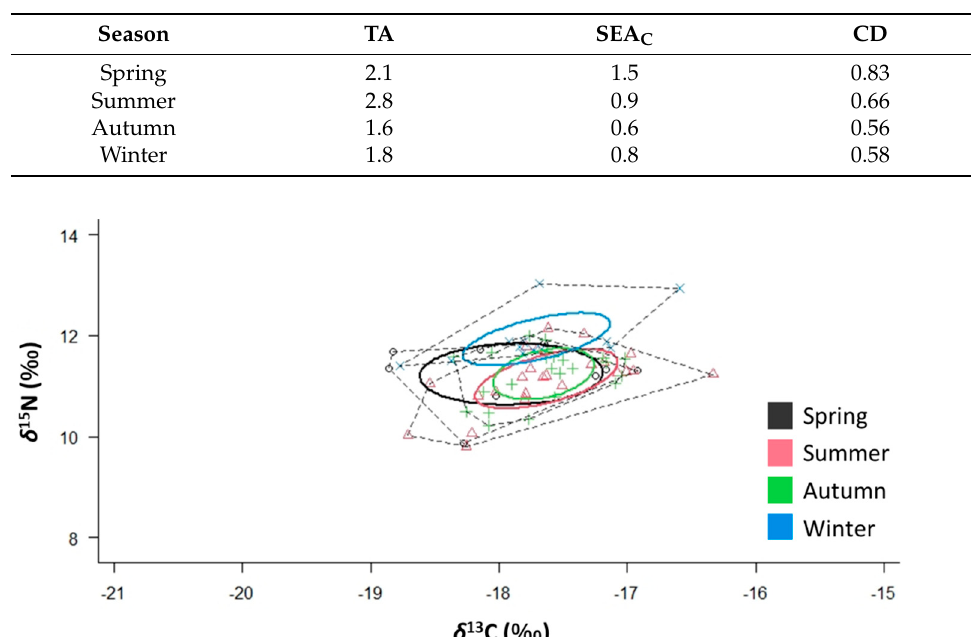
Figure 7. Posterior probabilities for the proportional contribution of each food source to the diet of n = 68 specimens of Solea solea captured from January to December 2019 in the Central Adriatic Sea in ( A ) spring, ( B ) summer, ( C ) autumn, and ( D ) winter obtained with stable isotope analysis mixing models. Each plot shows the proportions for each food. The horizontal line within the box represents the median and the 95% credibility interval, boxplots represent the 25th%, 50th%, and 75th% percentiles, while the whisker lengths represent the 1.5 interquartile range. Table 2. Values of the Total Area of the convex hull (TA), the corrected Standard Ellipse Area (SEA C ), and the distance from the centroid (CD) calculated considering the factor “Season” on the isotopic contents of n = 68 specimens of Solea solea captured from January to December 2019 in the Central Adriatic Sea for a study of their diet. TA and SEA C are expressed as ‰ 2 .